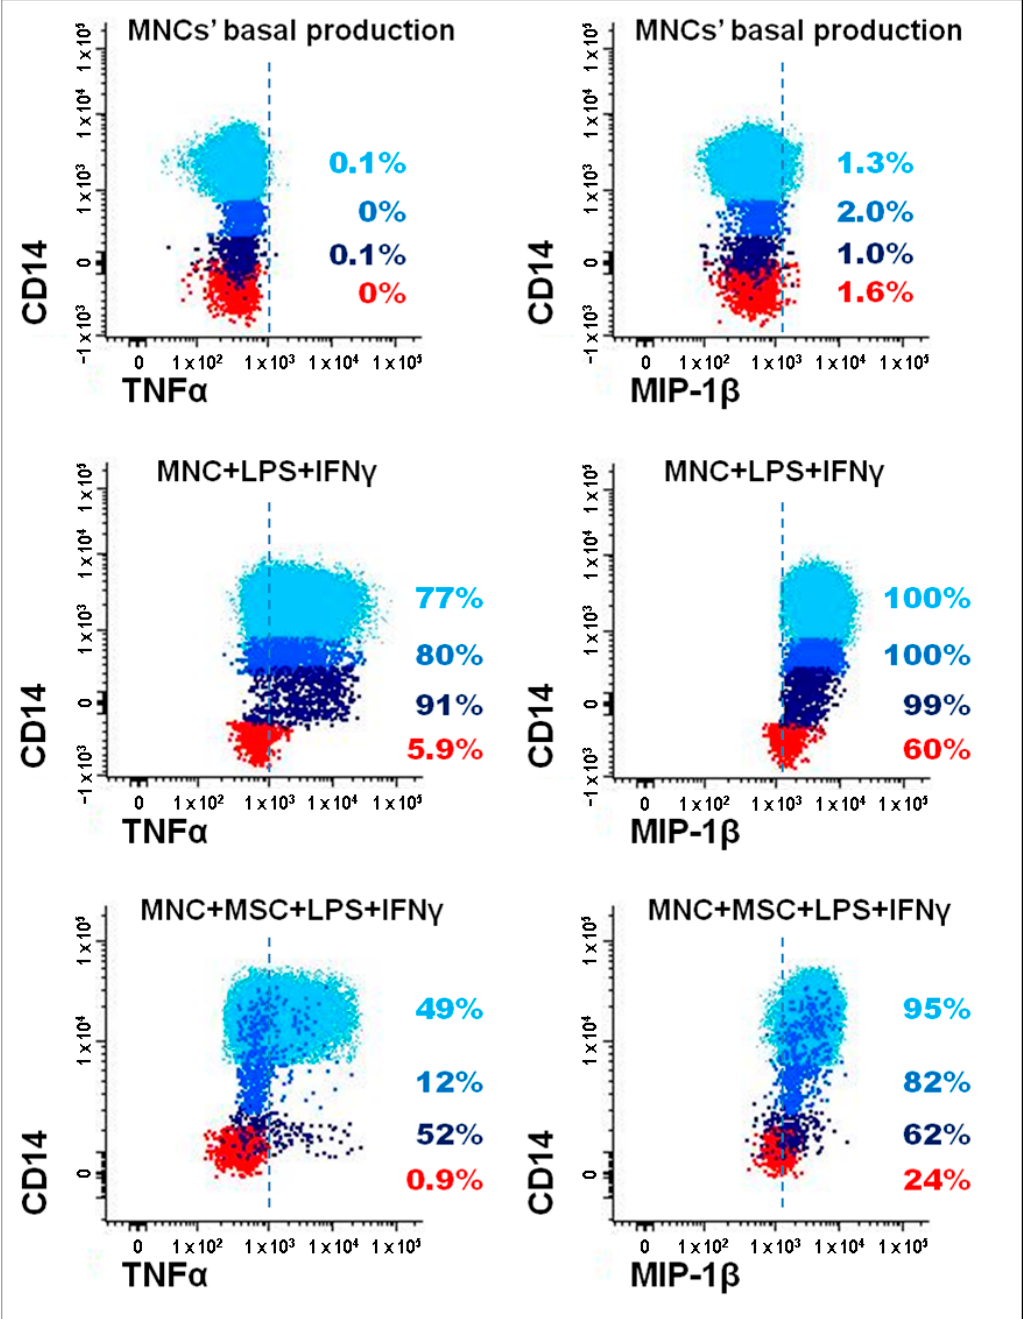
Figure 2. Identification of monocyte subpopulations and mDCs producing TNF- α and MIP-1 β . Bivariate dot plot histograms depicting the gating strategy to identify TNF- α and MIP-1 β producing cells, among monocyte subpopulations and mDCs, from a healthy individual included in the control group. Classical monocytes correspond to light blue events, intermediate monocytes are represented in blue, dark blue events correspond to non-classical monocytes, and mDCs are represented as red events. TNF- α and MIP-1 β protein levels quantification is represented for three different culture conditions: unstimulated PBMCs (MNCs’ basal production), PBMCs stimulated with LPS and IFN γ (MNC + LPS+ IFN γ ), and PBMCs stimulated with LPS and IFN γ in co-culture with MSCs (MNC + MSC + LPS IFN γ ). IFN γ , interferon γ ; LPS, lipopolysaccharide; mDCs, myeloid dendritic cells; MIP-1 β , macrophage inflammatory protein-1 β ; MSCs, mesenchymal stromal/stem cells; PBMCs, peripheral blood mononuclear cells; TNF- α , tumor necrosis factor α .